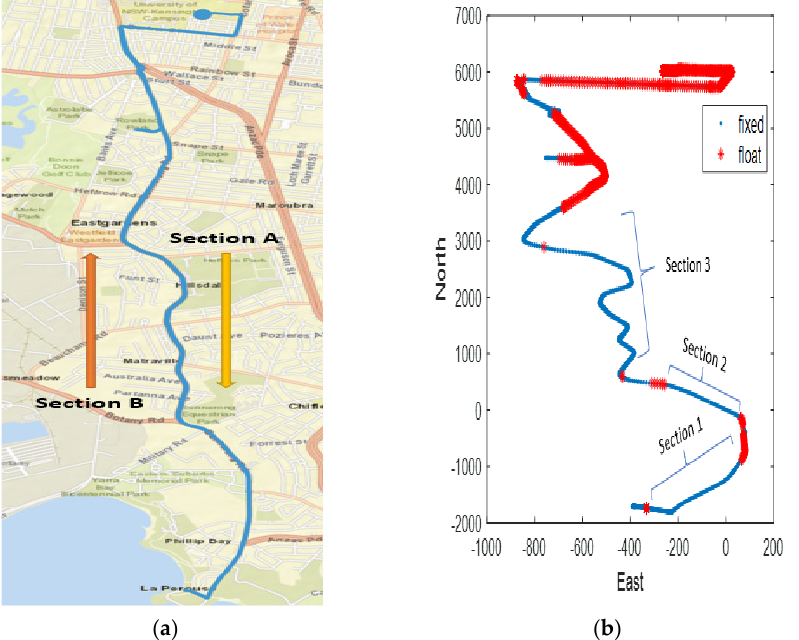
Figure 6. ( a ) The road test trajectory (in blue) on Google Maps; ( b ) GNSS/INS localization of the whole trajectory with RTK positioning status in a local coordinate system. whole trajectory with RTK positioning status in a local coordinate